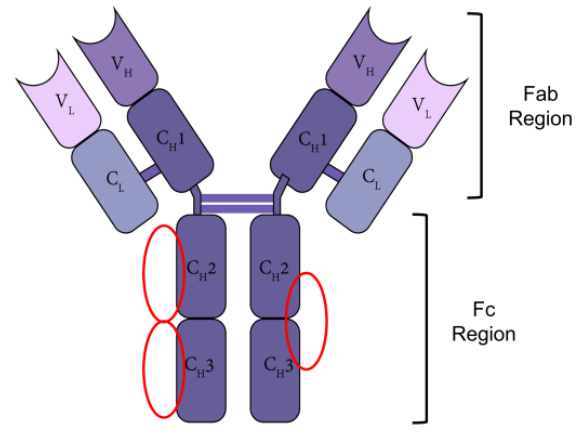
Figure 1. The structure of IgG and the main binding site of IgG Fc affinity ligands; the main binding sites of IgG Fc affinity ligands are shown in red circles.